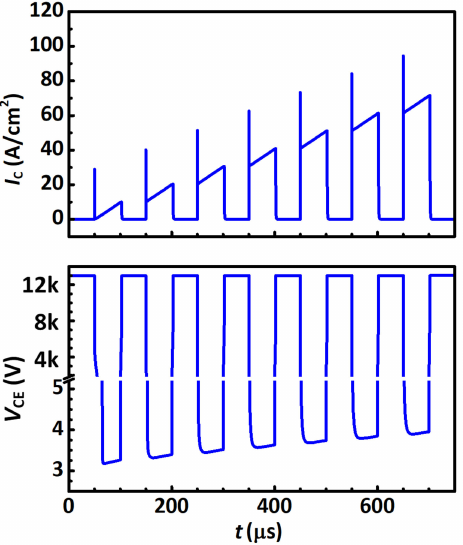
Figure 9. Multi-cycle switching curves ( I C and V CE ) of the proposed IGBT.